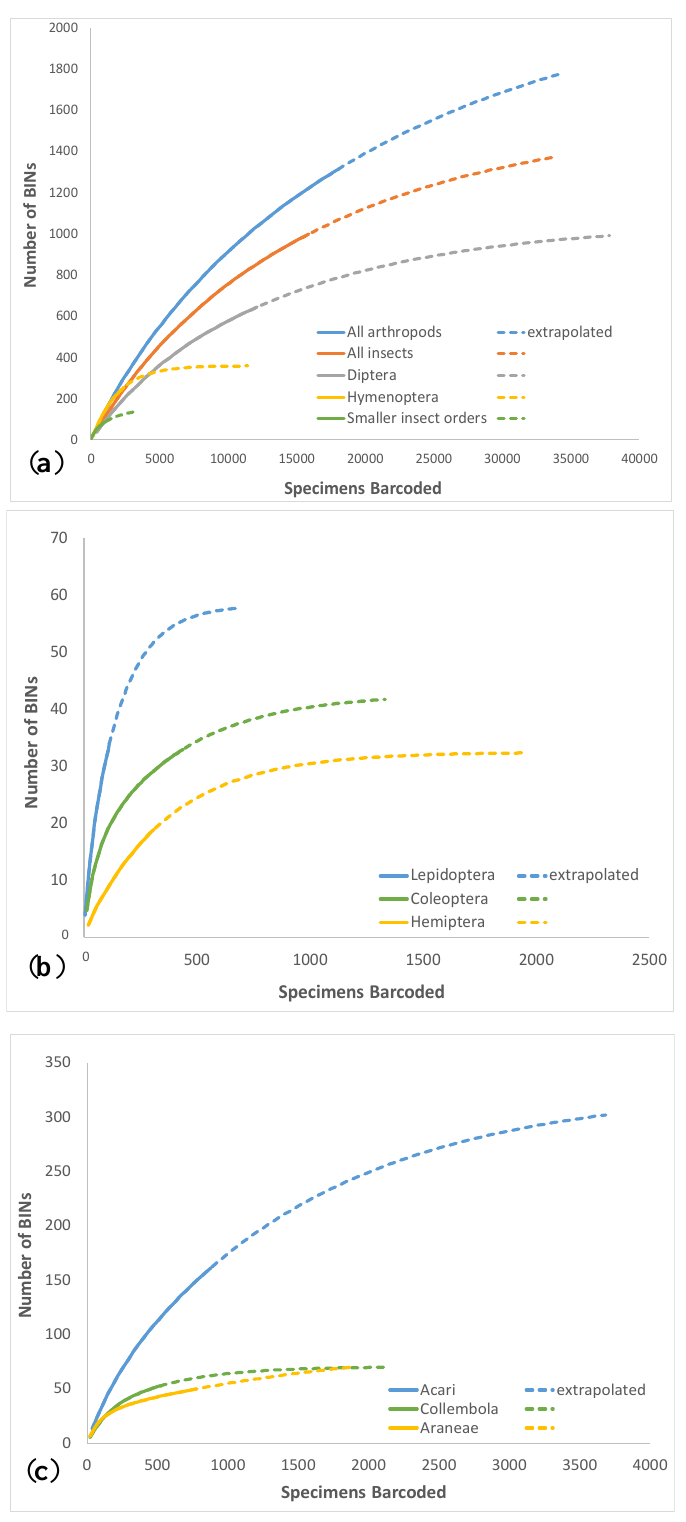
Figure 2. Accumulation curves estimated for different arthropod groups using EstimateS. ( a ) Most abundant insects; ( b ) less abundant insect orders; ( c ) non-insect terrestrial and soil arthropods.